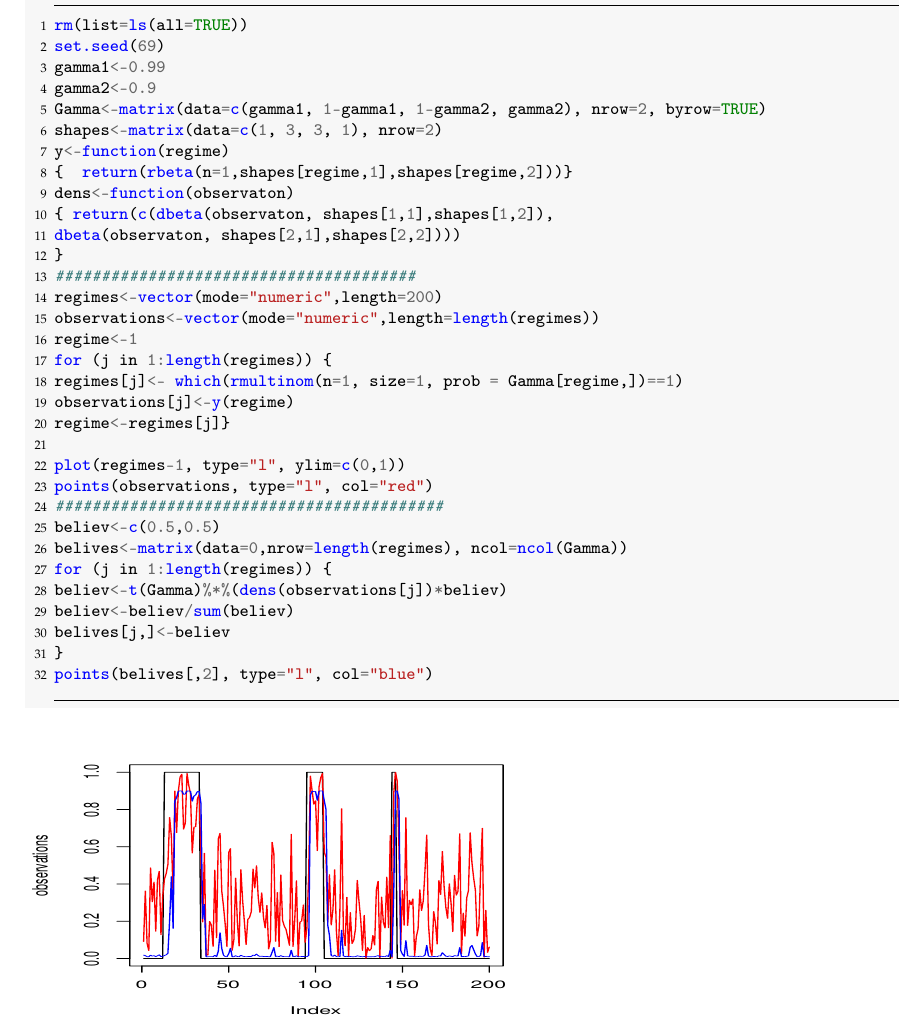
Figure 2. Believe state evolution: Observations depicted by red line, the probability that the system is in the regime 2 by black (true state) and blue (filtered believe)